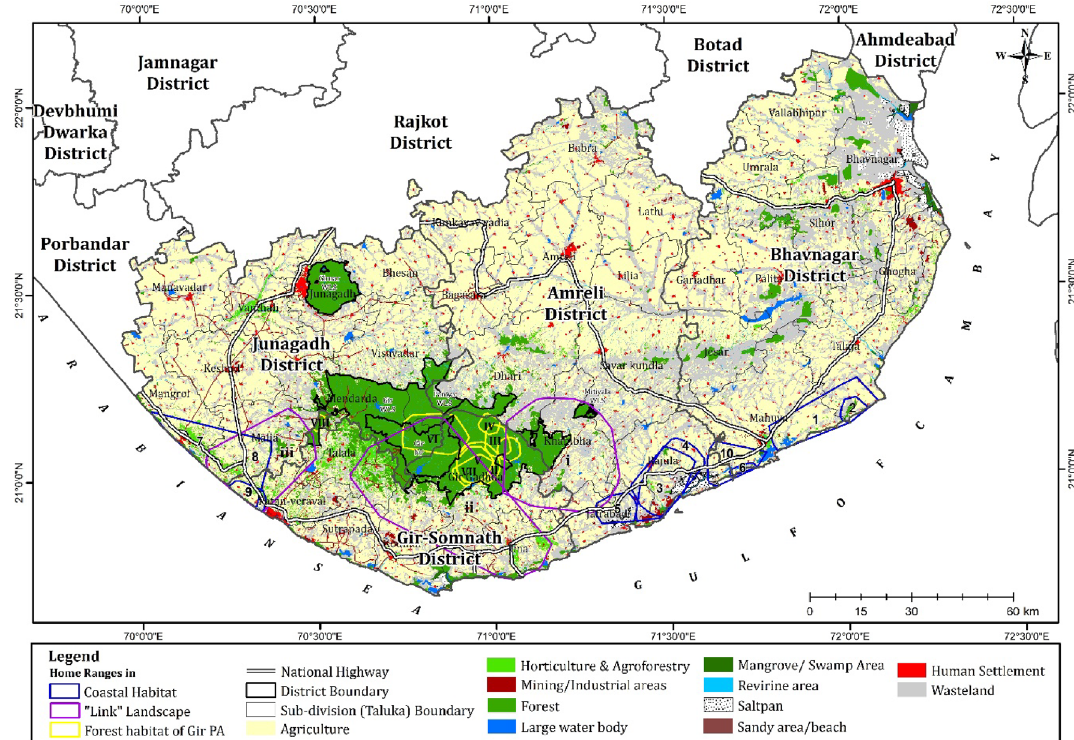
Figure 2. Land Use Land Cover (LULC) of eastern and western coastal lion habitats. The figure also indicates the distribution of radio-collared lions ranging in the (i) coastal habitats, (ii) “link” landscape between the Gir PA and the coastal habitats, and (iii) forested habitats of the Gir